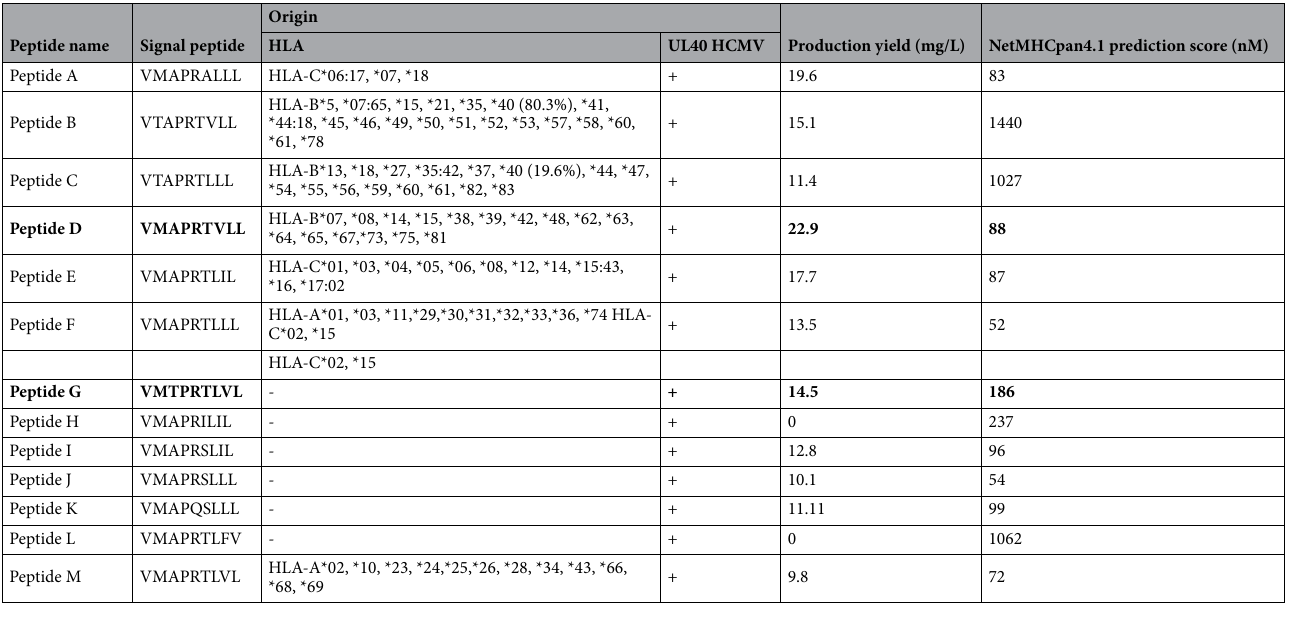
Table 1. Sequences of HLA-E/UL40 peptides and yields of corresponding complexes produced using a batch protocol. Peptides D and G in bold character represent peptides selected for the design of photosensitive